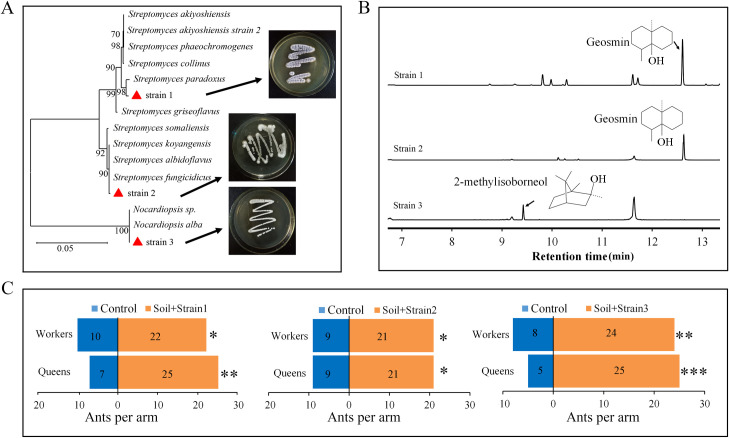
Volatiles of actinobacterial strains attract S. invicta ants.(A) Molecular phylogenetic analysis of actinobacterial strains isolated from soil from favored nesting sites and identified based on their 16S rRNA gene sequences. Tree was constructed with a maximum likelihood estimation method. Branch support is indicated as bootstrap values (500 replicates). Red triangles indicate the isolated bacteria. (B) Typical gas chromatographic traces of the headspace of isolated bacterial cultures showing the identified volatiles. (C) Attraction of S. invicta in a Y-tube olfactometer to the isolated bacteria when added to soil from non-favored nesting areas (n ≥ 30 biological replicates, chi-square test). Control: soil from non-favored nesting areas. Asterisks indicate significant differences (*P < 0.05, **P < 0.01, ***P < 0.001).